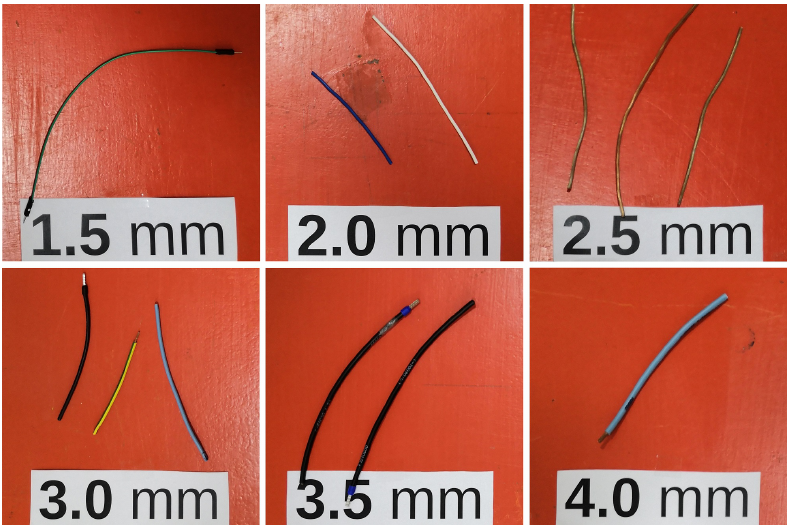
Figure 9. Wires used for the sorting